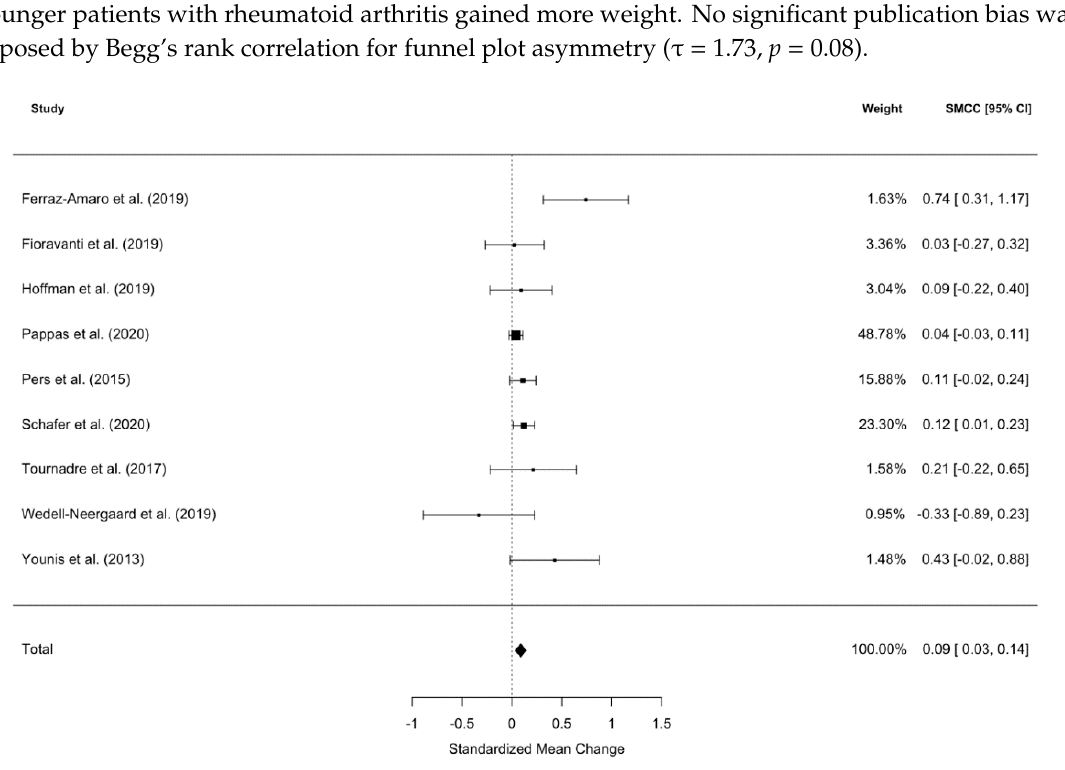
Figure 1. Forest plot of standardized mean change in body weight from nine datasets ( n = 1531). Zero indicates no e ff ect, whereas points to the right indicate an increase in weight when comparing baseline with follow-up values post-treatment with an IL-6 signaling pathway inhibitor.